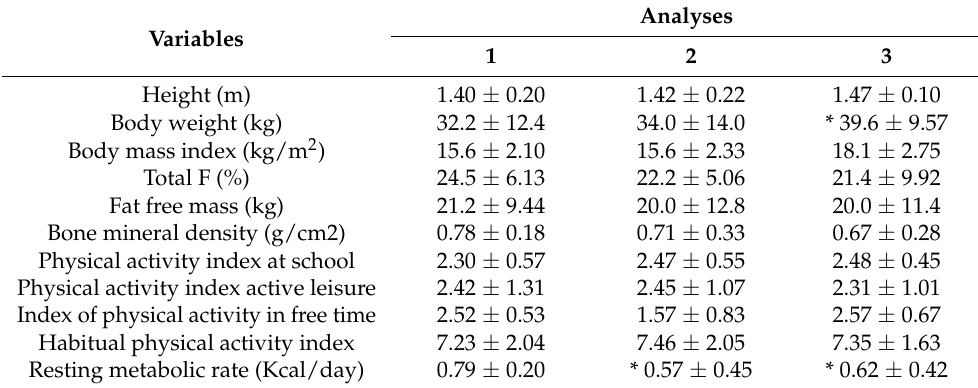
Table 2. The behavior of the variables body composition, bone mineral density, habitual physical activity level, and resting metabolic rate of the sample in each period of analysis.